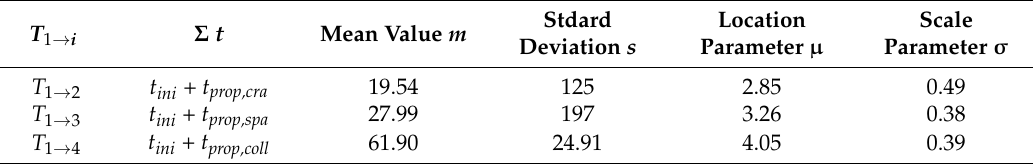
Table 19. Sums of sojourn times T 1 → i . of the process of carbonation-induced corrosion in the wings of the Weikendorf